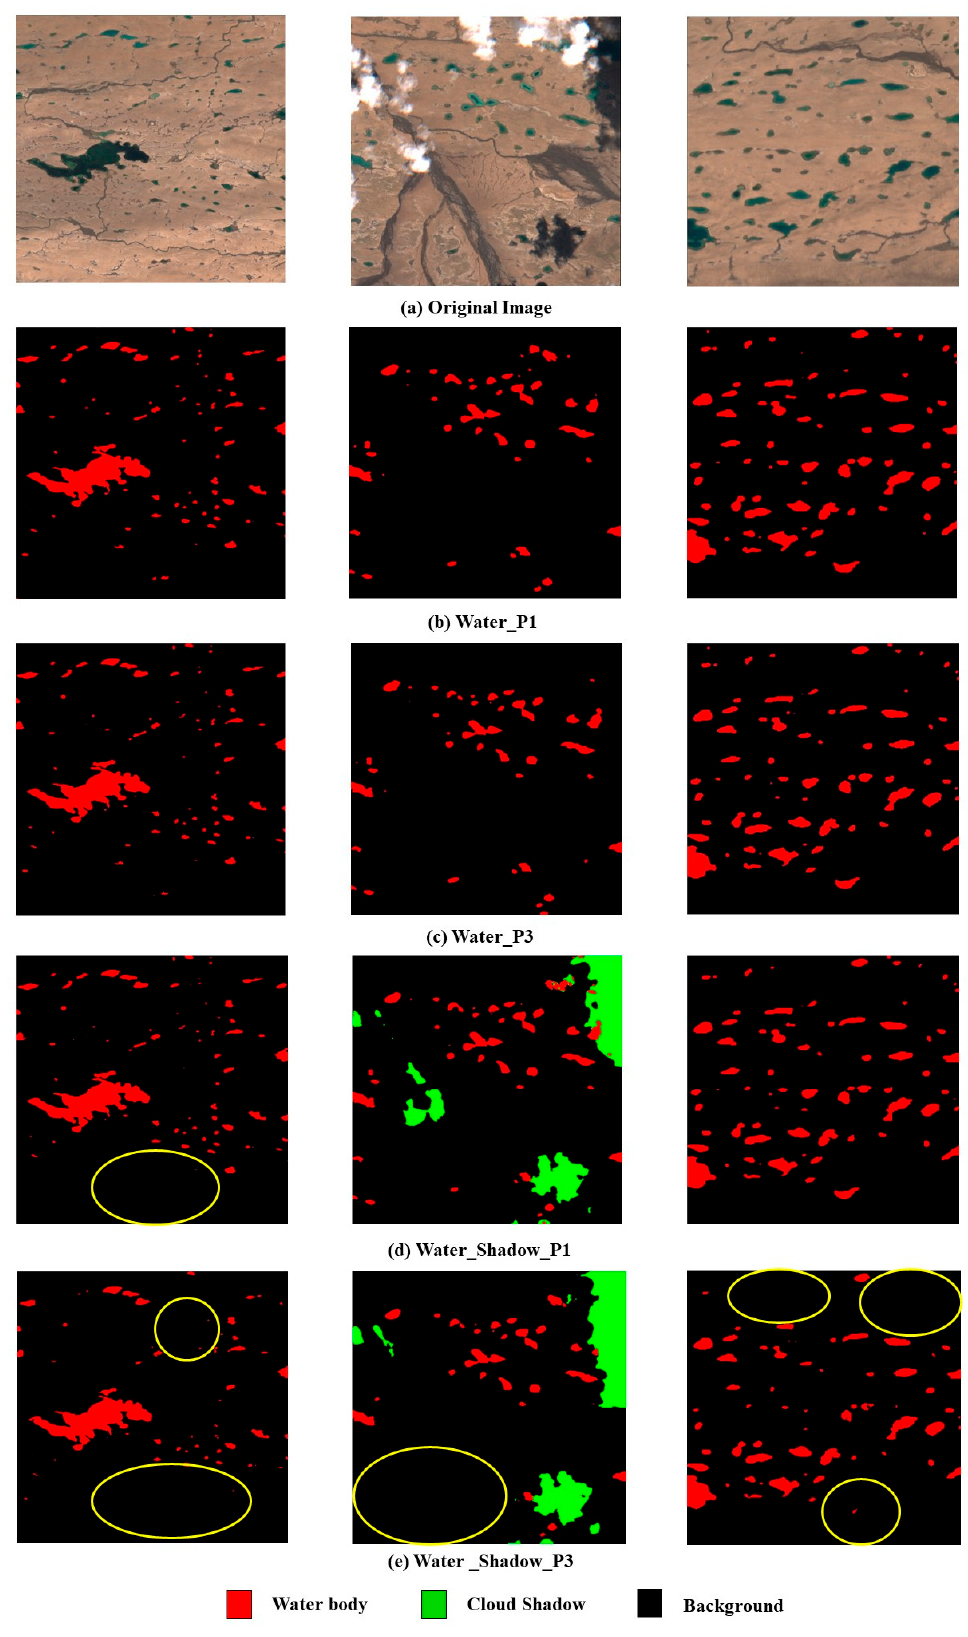
Figure 6. Results of water bodies being missed (The areas circled in yellow represent the water bodies being missed).